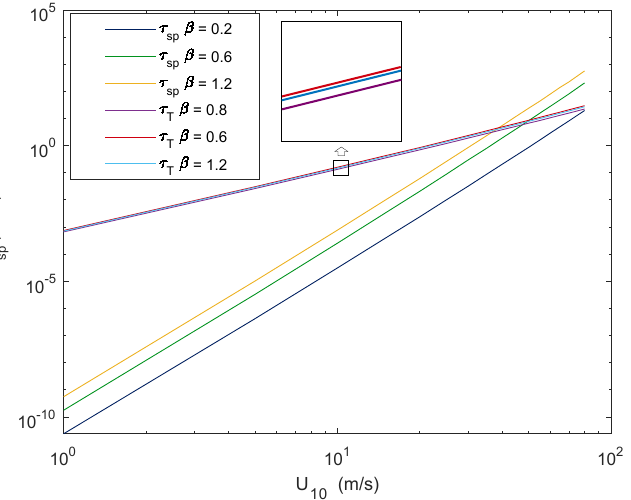
Figure 2. Variations of the spray momentum flux and total momentum flux, as a function of wind speed under different wave ages.